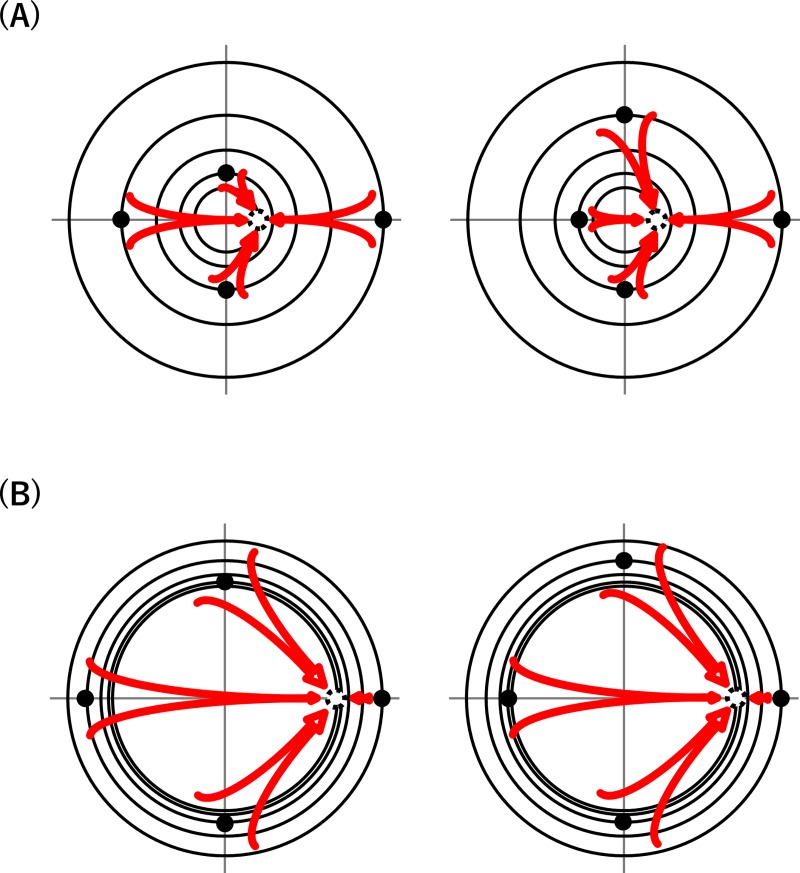
Schematic explanation of two conditions that enable orixate phyllotaxis formation.(A) Gradual increase of the inhibitory power with a relatively small size of SAM. (B) Sudden decrease of the inhibitory power with a relatively large size of SAM. EDC1 can establish orixate phyllotaxis under either of these conditions while EDC2 can only under the former condition.